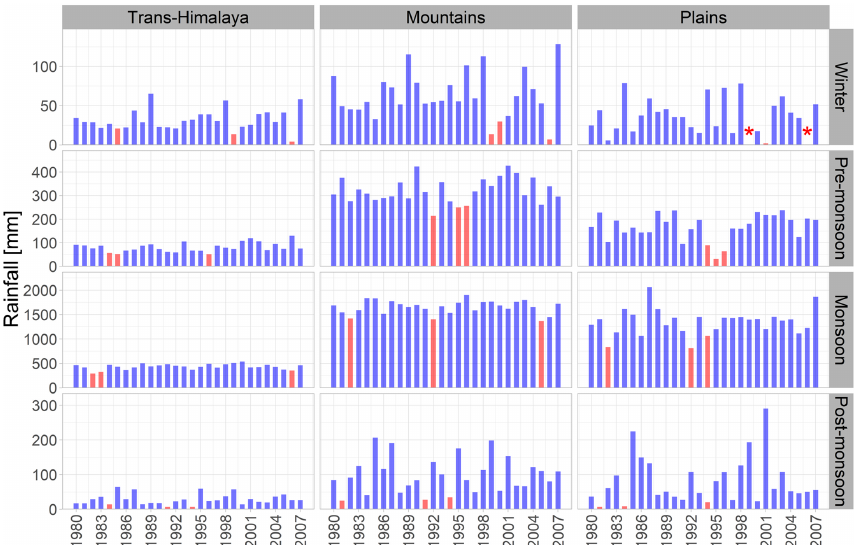
Figure 5. Seasonal variability in precipitation in the KRB (1980–2007). Note: the red bars indicate the three lowest precipitation years, and the stars indicate no rainfall.